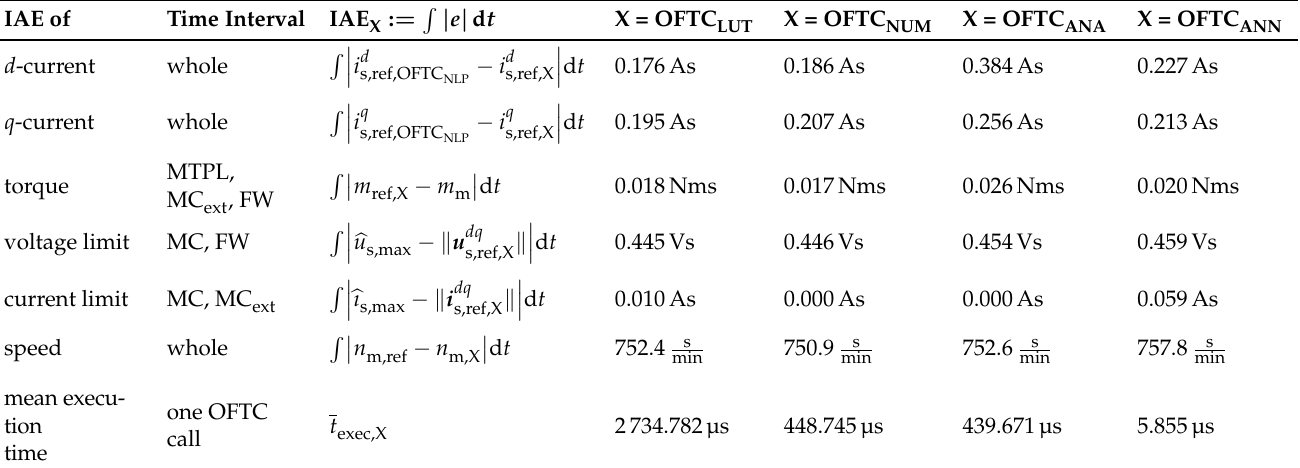
Table 8. Comparison of the time series of the implementation results of OFTC OFTC NUM (OFTC with numerical ORCC), OFTC ANA (OFTC with analytical ORCC) and proposed OFTC ANN (ANN-based OFTC) against OFTC NLP (OFTC with fmincon -based ORCC) evaluating the Integral Absolute Error (IAE) performance measure and the executation